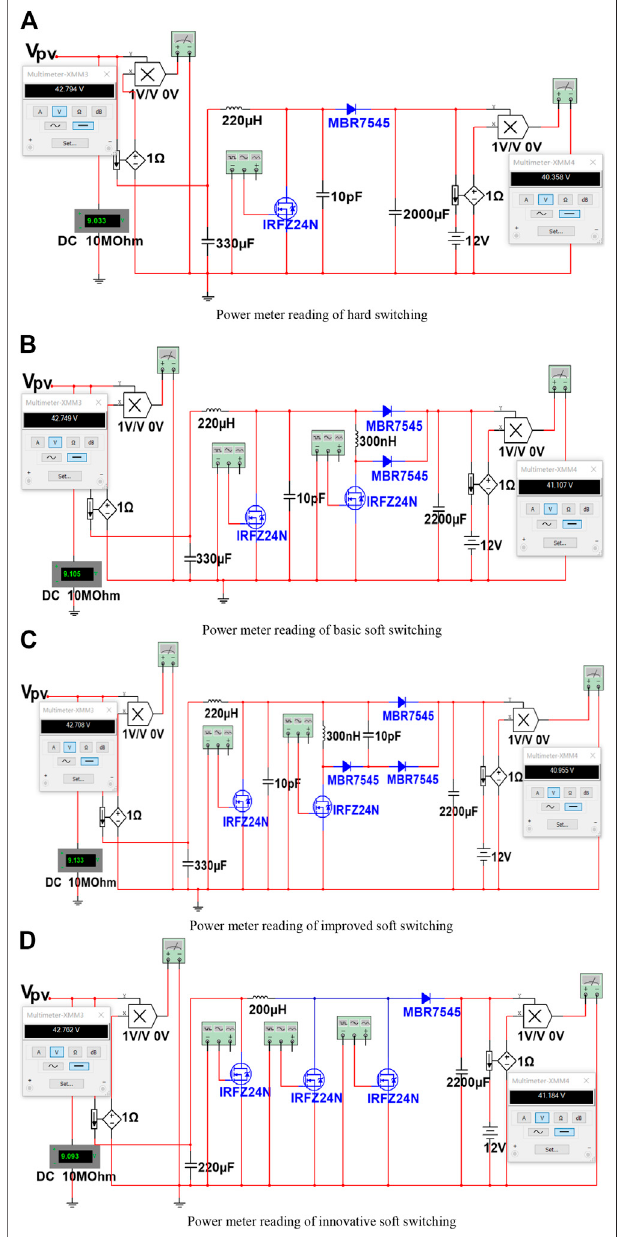
FIGURE 13 | Power meter readings for hard and soft switches.